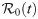
The fitting results for θ = 0.5 and η = 0.3.The fitting results in the main panel show the best scenario, which attains the smallest BIC. The red line is the mean GBS cases averaged from 1000 simulations plotted as a function of time. The dashed blue curve is the R0(t) estimate which minimizes the BIC, and the green region shows the 95% of confidence interval R0(t). The grey shaded area shows the 95% CI of the simulated GBS cases. The inset panel shows the profile of BIC as a function of ρ. The minimum occurs at ρ = 0.000061, which is our best estimate for ρ.